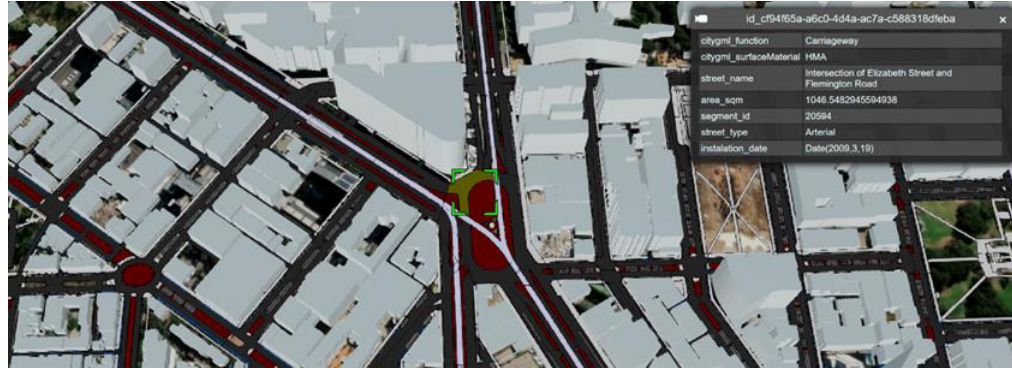
Figure 12. Streetspace model of Melbourne (near intersection of Flemington Rd and Elizabeth St).